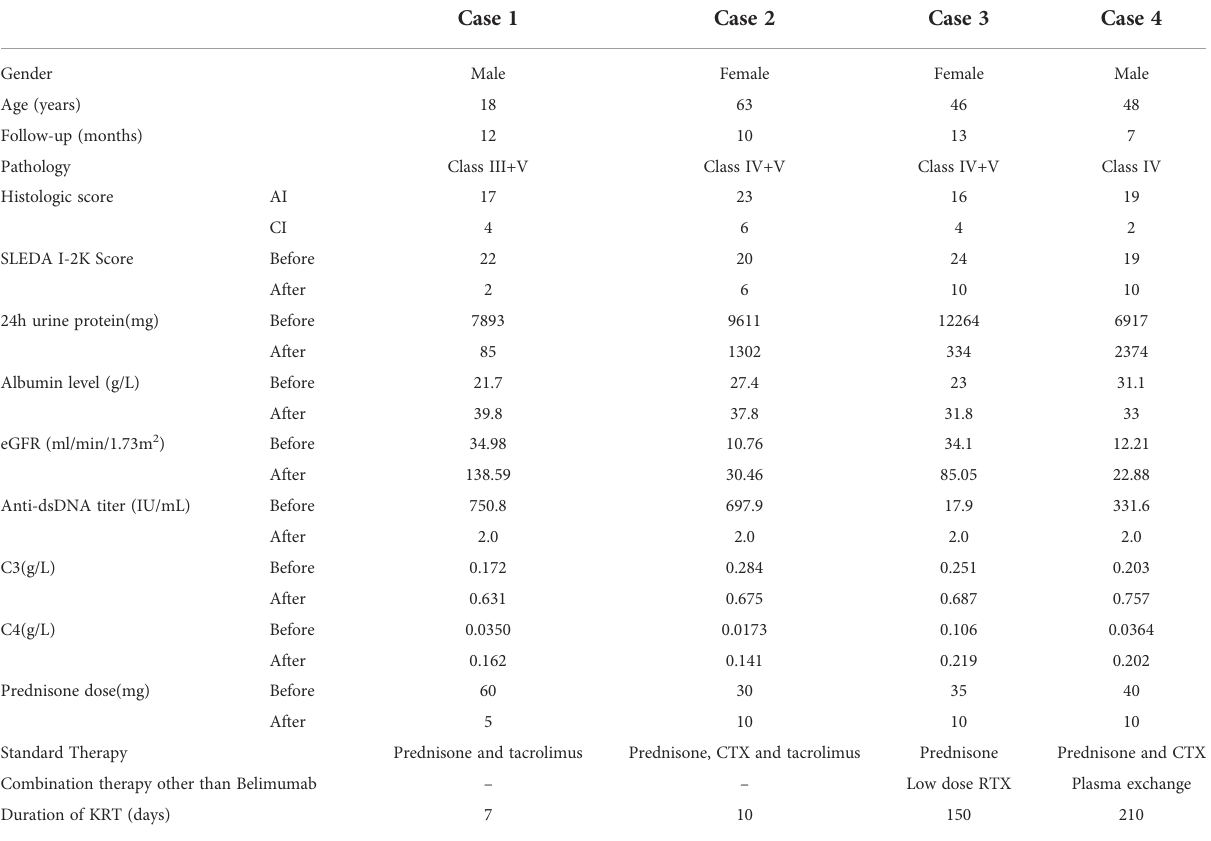
TABLE 1 Characteristics of patients before and after Belimumab